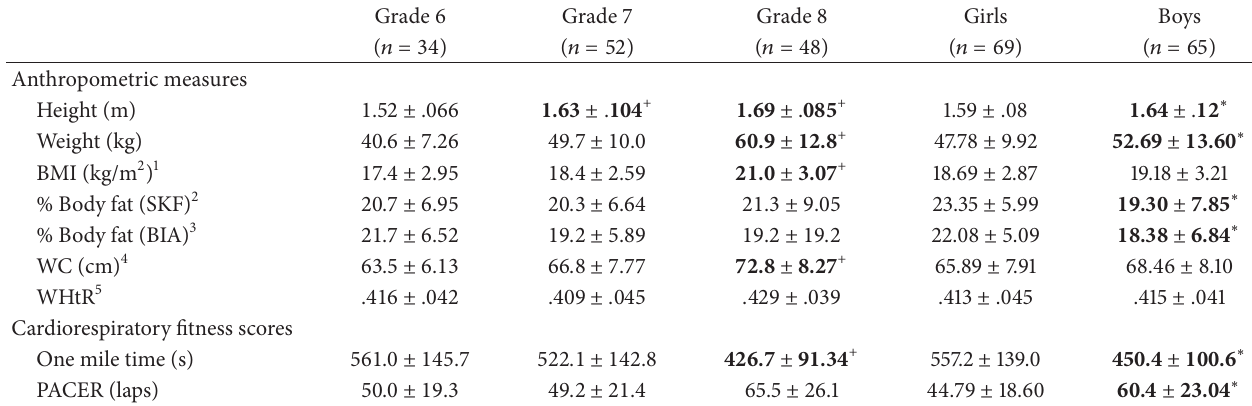
Table 1: Anthropometric measures and cardiorespiratory fitness scores per grade and gender group (means ± S.D.).